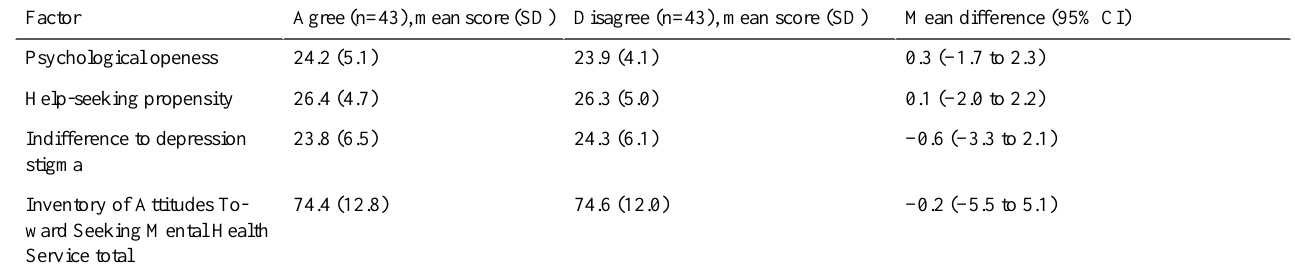
Table 3. Inventory of Attitudes Toward Seeking Mental Health Services factor scores by agreement with using text messaging to communicate with a professional to receive help for managing